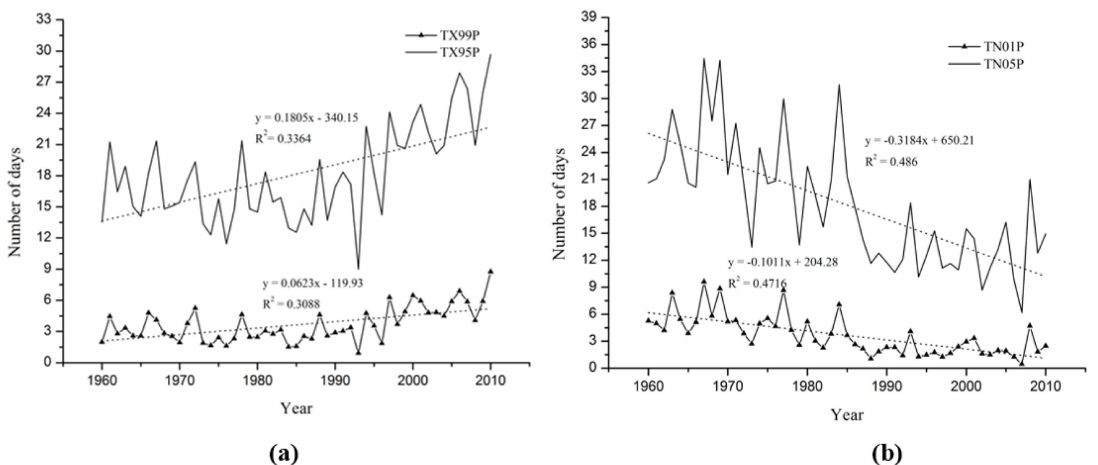
Figure 2. Time series of annual occurrences of warm days (TX95p), hot days (TX99p), cold nights (TN05p), and very cold nights (TN01p) in mainland China during 1960–2010. ( a ) Warm days (TX95p) are the upper lines and hot days (TX99p) are the lower lines; ( b ) cold nights (TN05p) are the upper lines and very cold nights (TN01p) are the lower lines. The dashed lines are linear trends that are statistically significant at p -value <